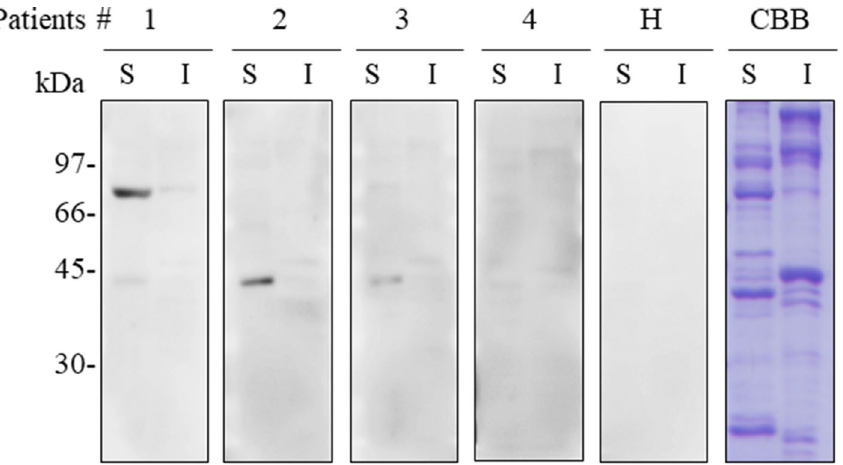
Figure 1. Immunoblot analysis of Tris-soluble and Tris-insoluble shrimp proteins from L. vannamei . Samples of the Tris-soluble (S) and Tris-insoluble (I) fractions (10 μg protein) were separated by SDS-PAGE and either stained with CBB or immunoblotted using a 1:10 dilution of sera from shrimp-FDEIA patients nos. 1–4 or a healthy subject (H). Full-length blots and a gel are presented in Supplementary Figure